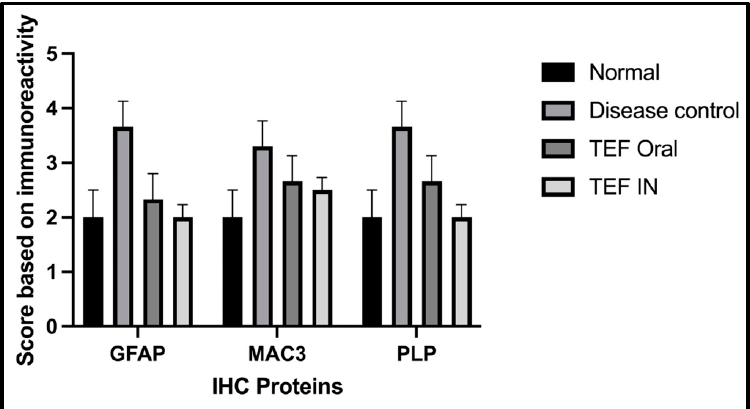
Figure 11. An unbiased semi-quantitative scoring for the immunopositivity of the IHC stained sections of the study groups. The scale shows minimal (0) to severe (5) immunopositivity. The IN-administered TEF–miR-155-antagomir-loaded NLCs group has exhibited significant ( p < 0.005) recovery with minimal inflammation and demyelination compared to TEF oral